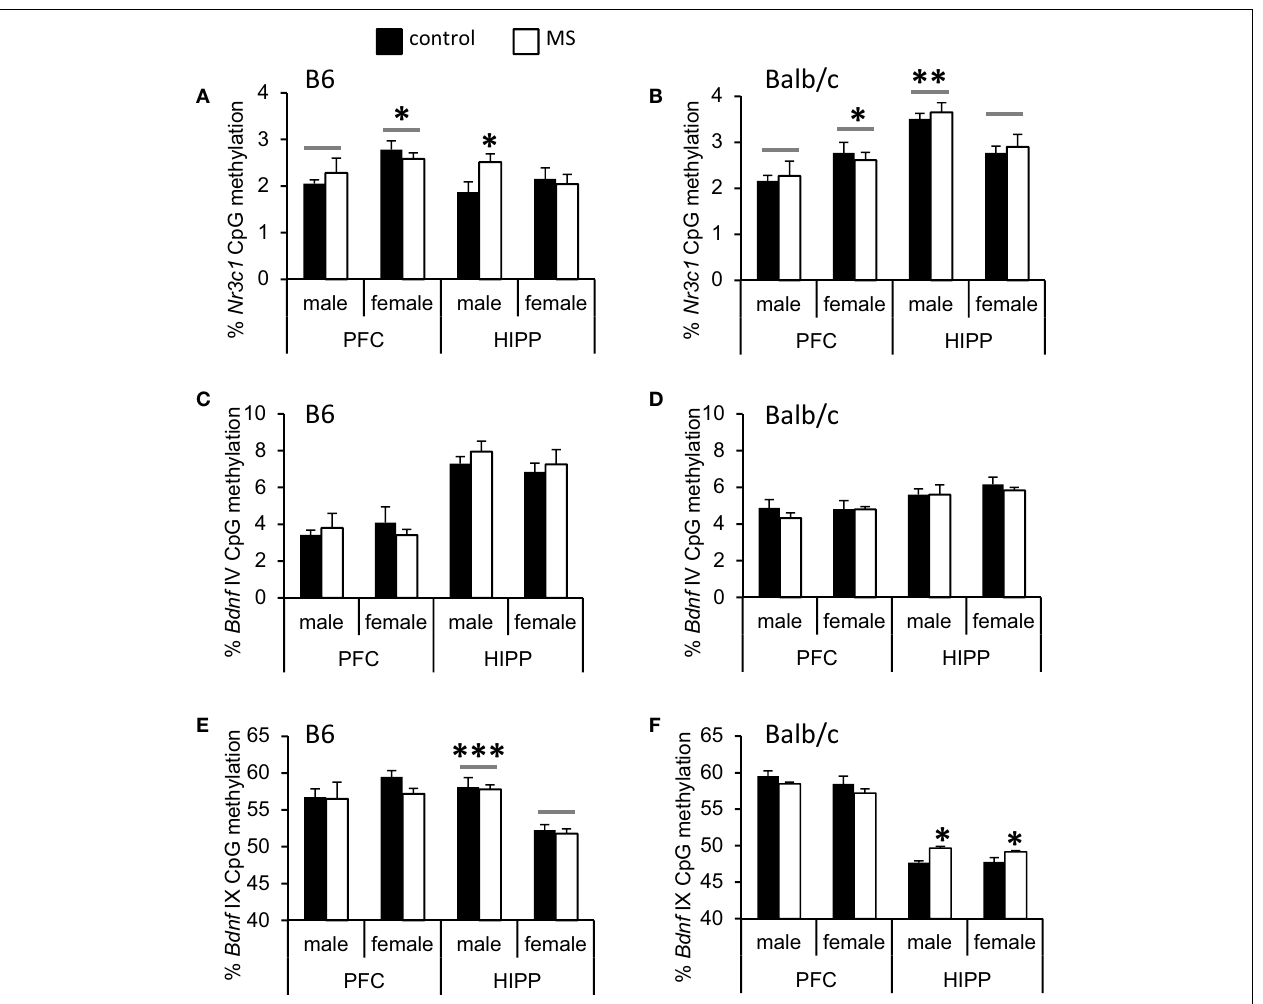
DNA methylation compared to males. Bdnf IV promoter DNA methylation was not altered by MS-rearing in (C) B6 or (D) Balb/c mice. MS-rearing had (E) no effect on Bdnf IX promoter DNA methylation in B6 mice but (F) increased DNA methylation of this region in the HIPP of Balb/c mice. In B6 mice, females had reduced Bdnf IX promoter DNA methylation in the hippocampus compared to males (indicated by gray bars). * p < 0.05, ** p < 0.01, *** p < 0.001 (control vs . MS comparisons or male vs . female